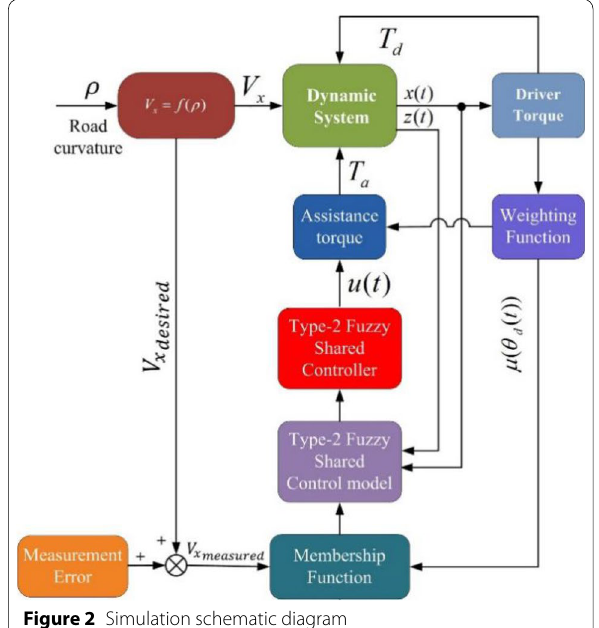
Figure 2 Simulation schematic